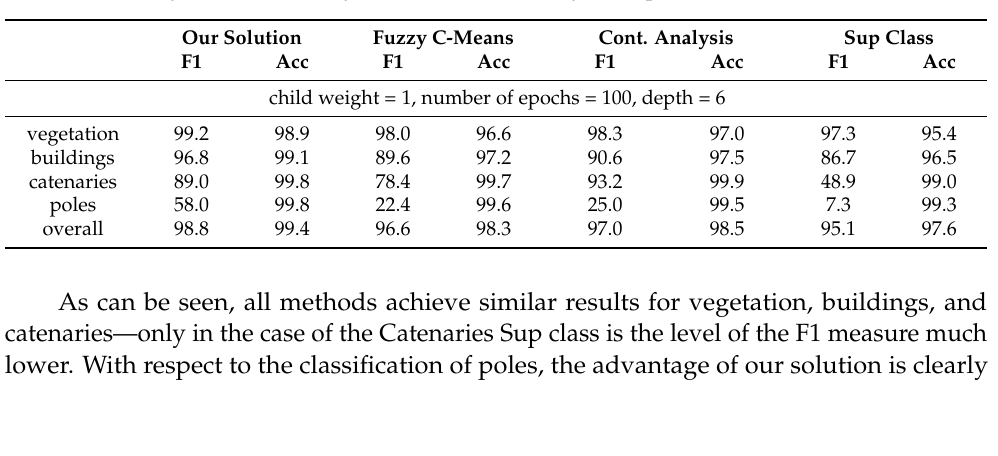
Table 4. Accuracy and F1 for CGAL random forests and XGBoost. vegetation